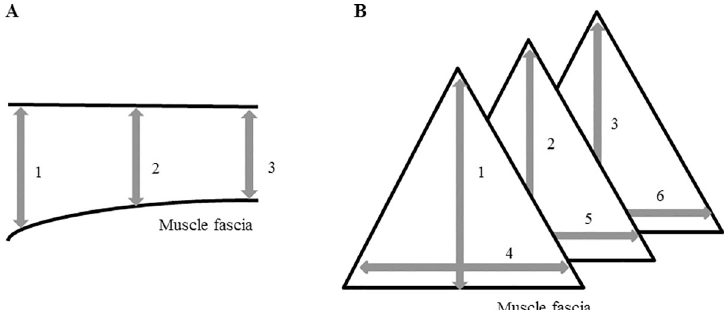
Fig 3. Ultrasonographic assessment of muscle morphometrics. (A) in spindle shaped muscles; (B): in triangular shaped